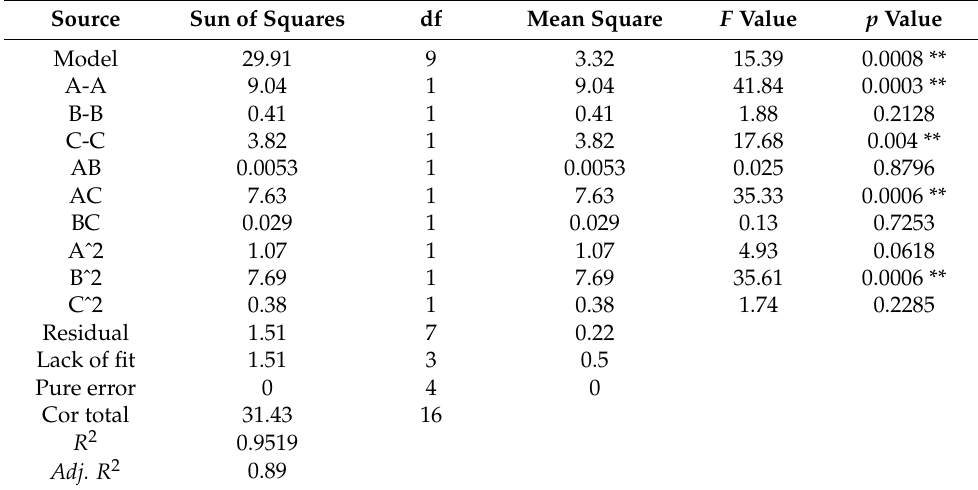
Table 3. Variance analysis of cutting